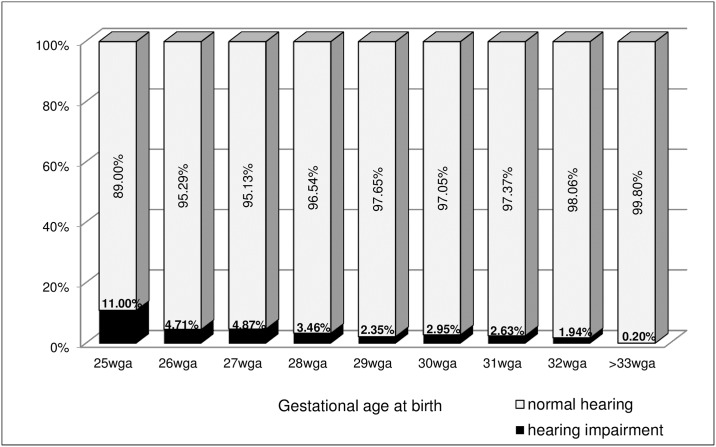
Flowchart of children registered in the central database of PUNHSP between 1 January 2013 and 31 December 2013.PUNSHP = Polish Universal Neonatal Hearing Screening Program; wga = week of gestational age.